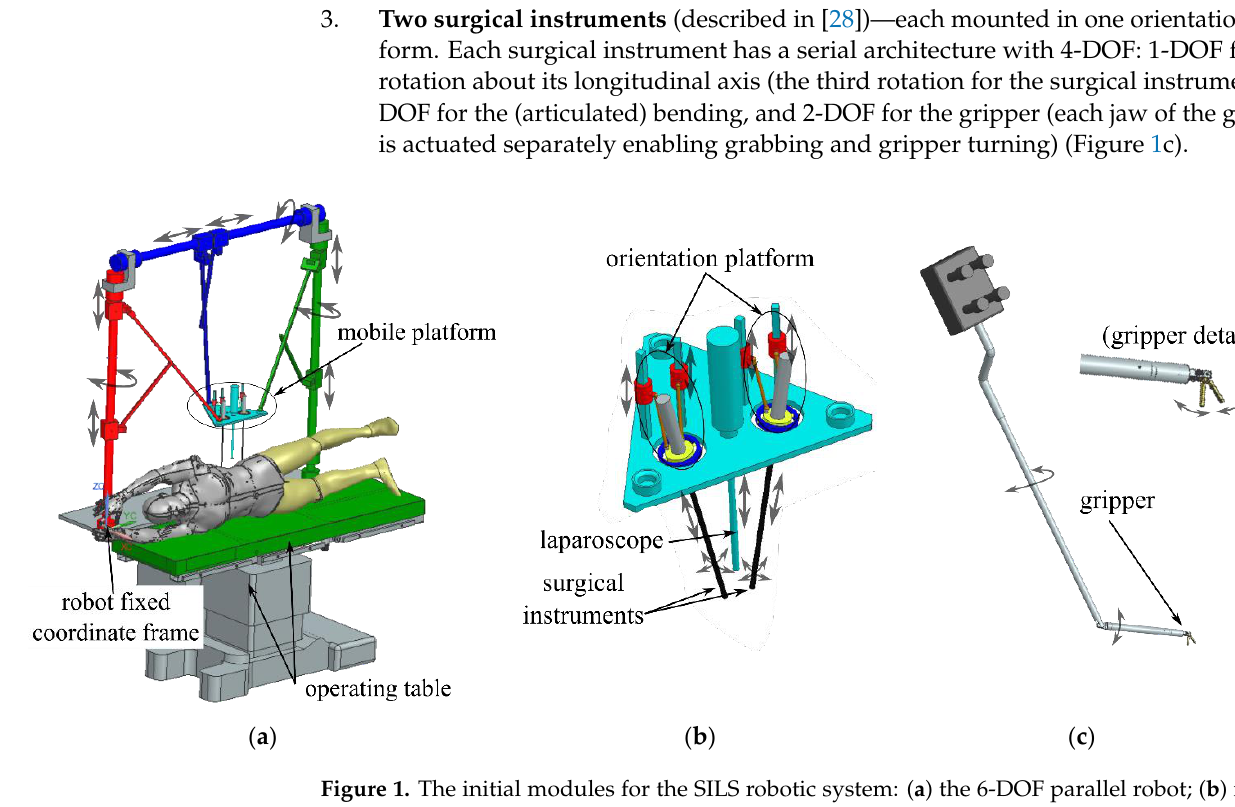
Figure 1. The initial modules for the SILS robotic system: ( a ) the 6-DOF parallel robot; ( b ) mobile platform containing the laparoscope and two orientation platforms; ( c ) surgical instrument.